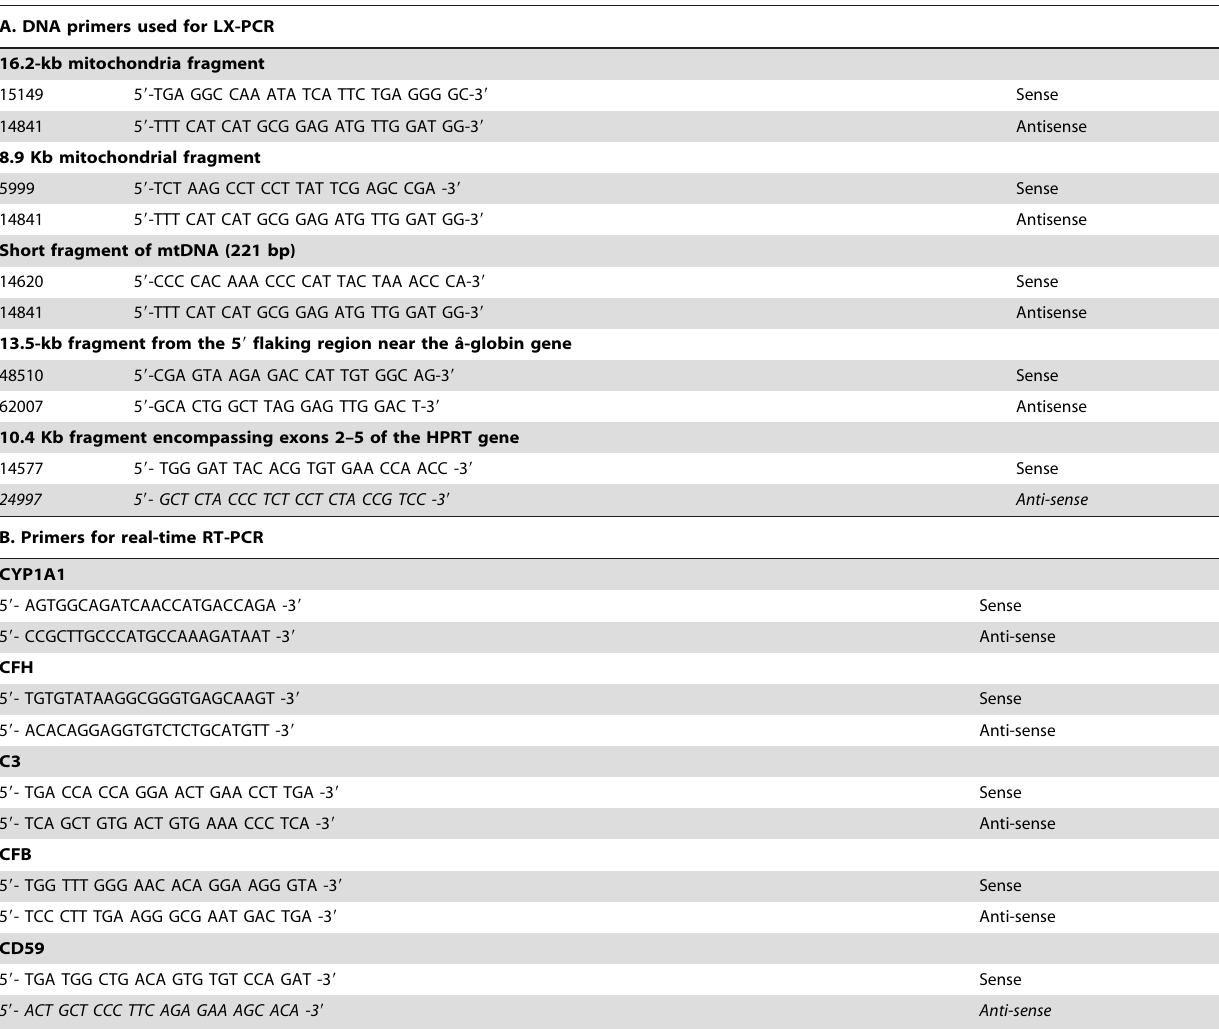
A. DNA primers used for